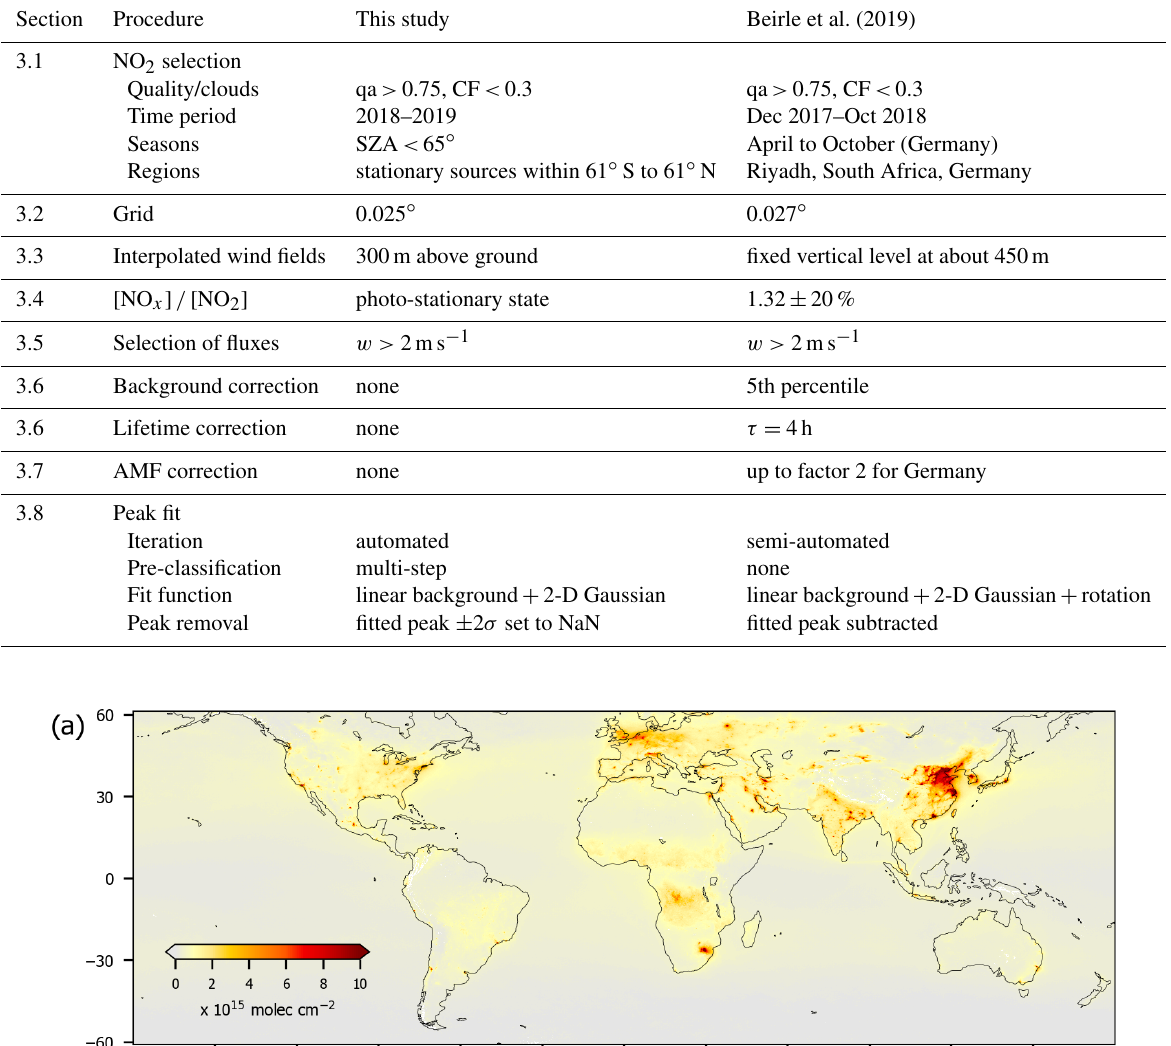
Table 1. Processing settings in this study as compared to Beirle et al. (2019).